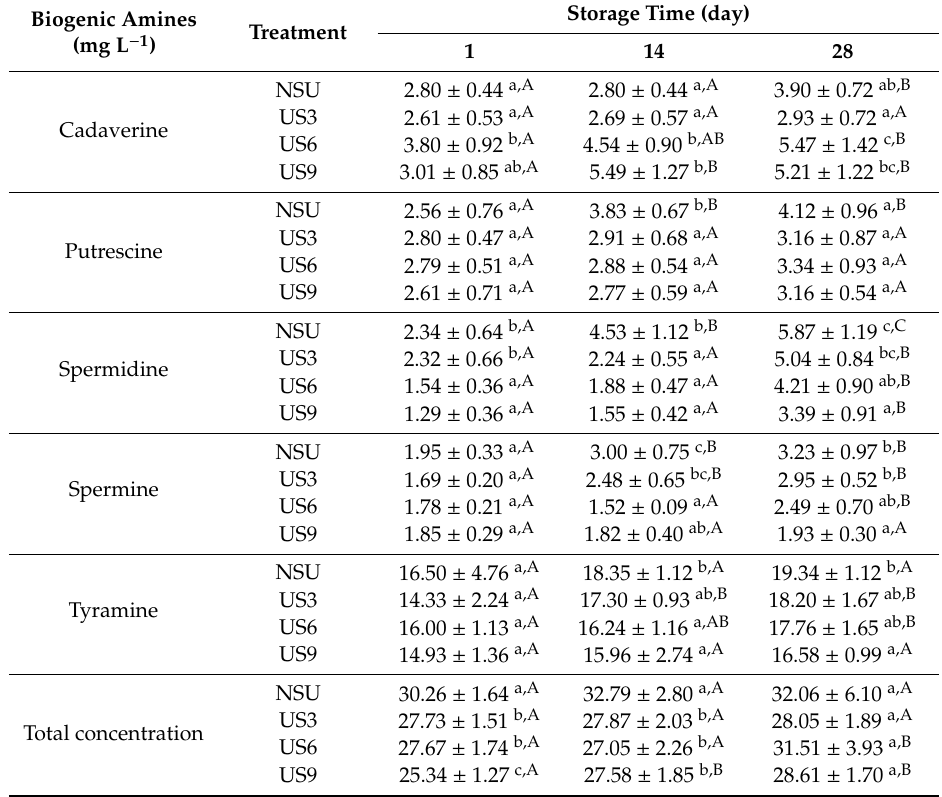
Table 3. Biogenic amine concentration in goat milk yogurt samples was measured during 28 days of storage at 4 ◦